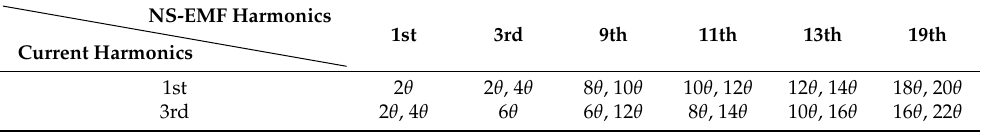
Table 2. Possible harmonic components of torque generated by NS-EMF harmonics and current harmonics of the considered seven-phase machine in faulty